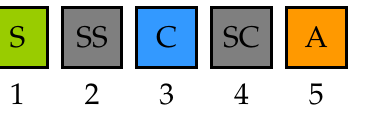
Figure 3. Execution phases of the example control application.